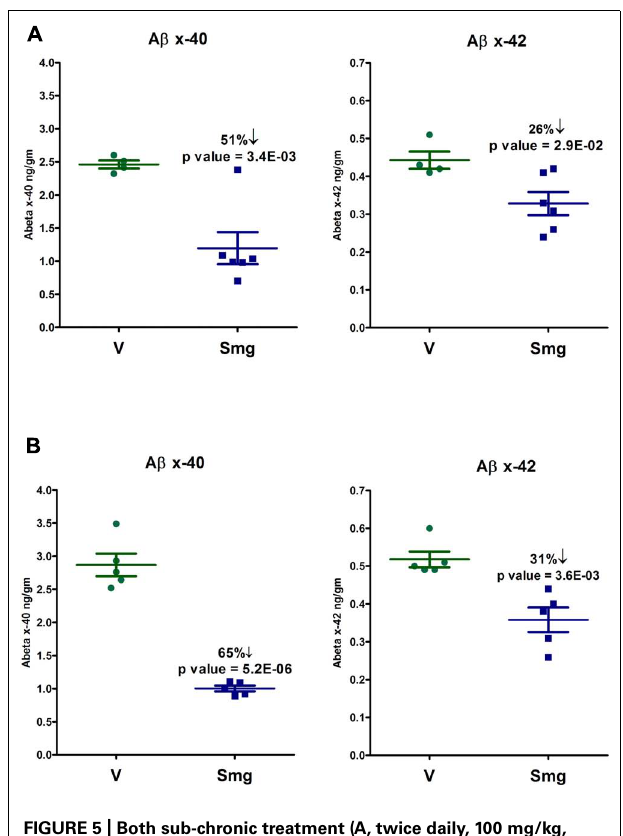
FIGURE 5 | Both sub-chronic treatment (A, twice daily, 100 mg/kg, p. o. over 12 days) and acute treatment (B, 100 mg/kg, s.c.) with semagacestat (Smg) significantly reduced brainA β levels compared to vehicle-treated controls.